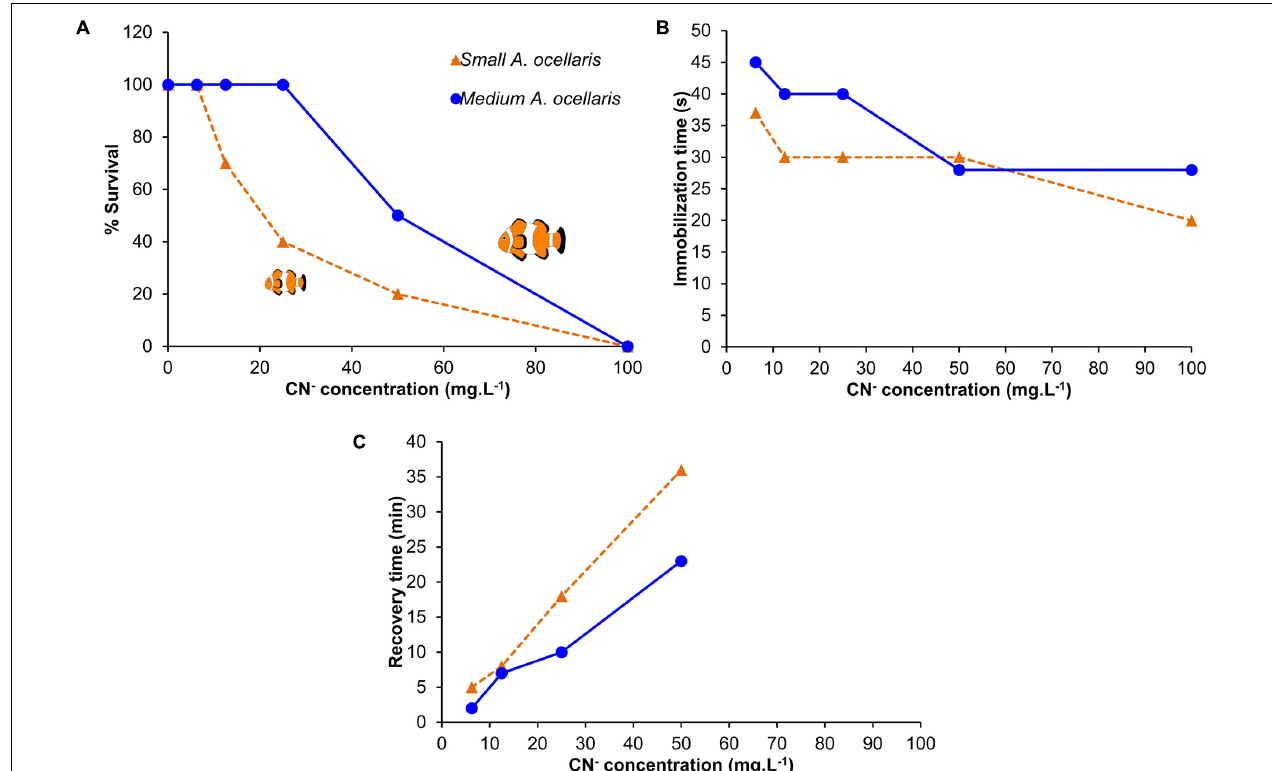
FIGURE 3 | Effects of cyanide (CN - ) pulse exposure (60 s) on different sized (small 25.00 ± 0.03 mm total length and 0.30 ± 0.09 g weight; medium 38.00 ± 0.02 mm total length and 1.12 ± 0.21 g weight) clownfish Amphiprion ocellaris (A) survival (%) 96-h post-exposure; (B) immobilization time (s); (C) recovery time (min). Ten small and medium-sized fish were used per treatment. Immobilization time is the time at which the last fish of a treatment stopped swimming and remained motionless while recovery time is the time at which the last fish of a treatment returned to normal swimming